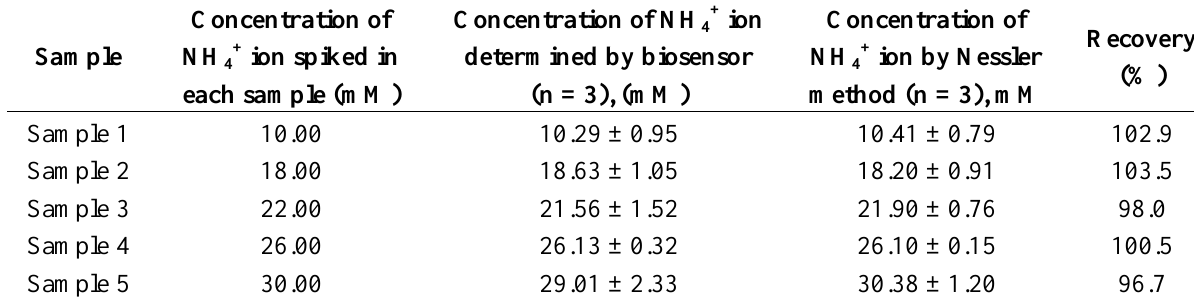
Table 3. A comparative study of the reagentless biosensor and Nessler method for NH 4+ ion analysis in different river water samples containing spiked NH 4+ ion concentrations from 10–30 mM.